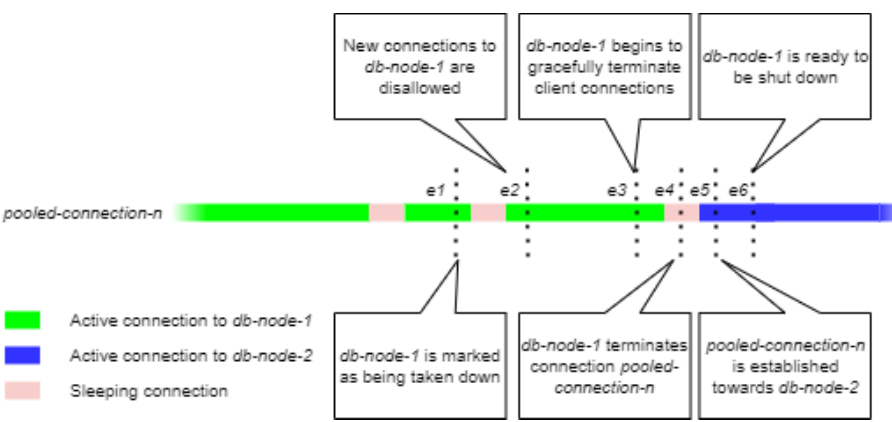
Figure 2. Client connection transition.